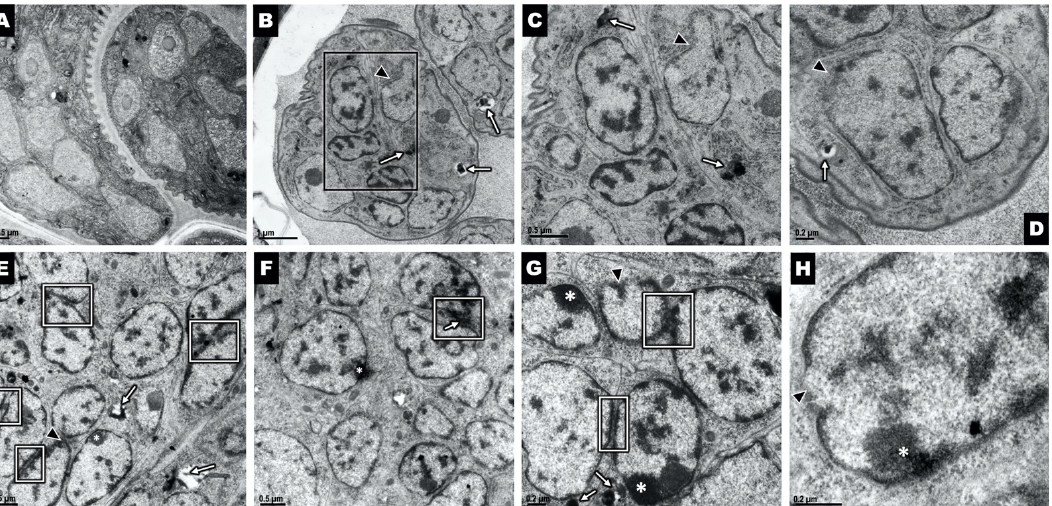
Figure 5. Ultrastructural analysis shows sub-cellular abnormalities in the gonads of the THP- and analog 06-treated worms. ( A ) Microphotograph of a female gonad from a control animal treated with vehicle alone. Cellular inclusions are rare and all nuclear envelopes appear intact. Images ( B – D ) are representative images of developing microfilariae inside the reproductive structures of female worms removed from animals treated with THP. The black arrowheads show disrupted nuclear envelopes while white arrows point to internal cellular aggregates. The black box in image B delineates the region seen at a higher magnification in image ( C ). Images ( E – H ) are representative images of developing microfilariae inside the gonad of female worms removed from animals treated with analog 06. The white boxes show nuclear membranes that are closely juxtaposed with one another, an unusual feature that may be due to the disruption of the main cellular membrane. White arrows point to aggregates within the cellular structures, which frequently occur at the surface of the nuclear envelope. Arrowheads point to disruption of the nuclear envelope which appears more advanced in worms treated with 06 compared to those treated with THP. The asterisks indicate abnormal accumulation of heterochromatin at the internal surface of the nuclear envelope.